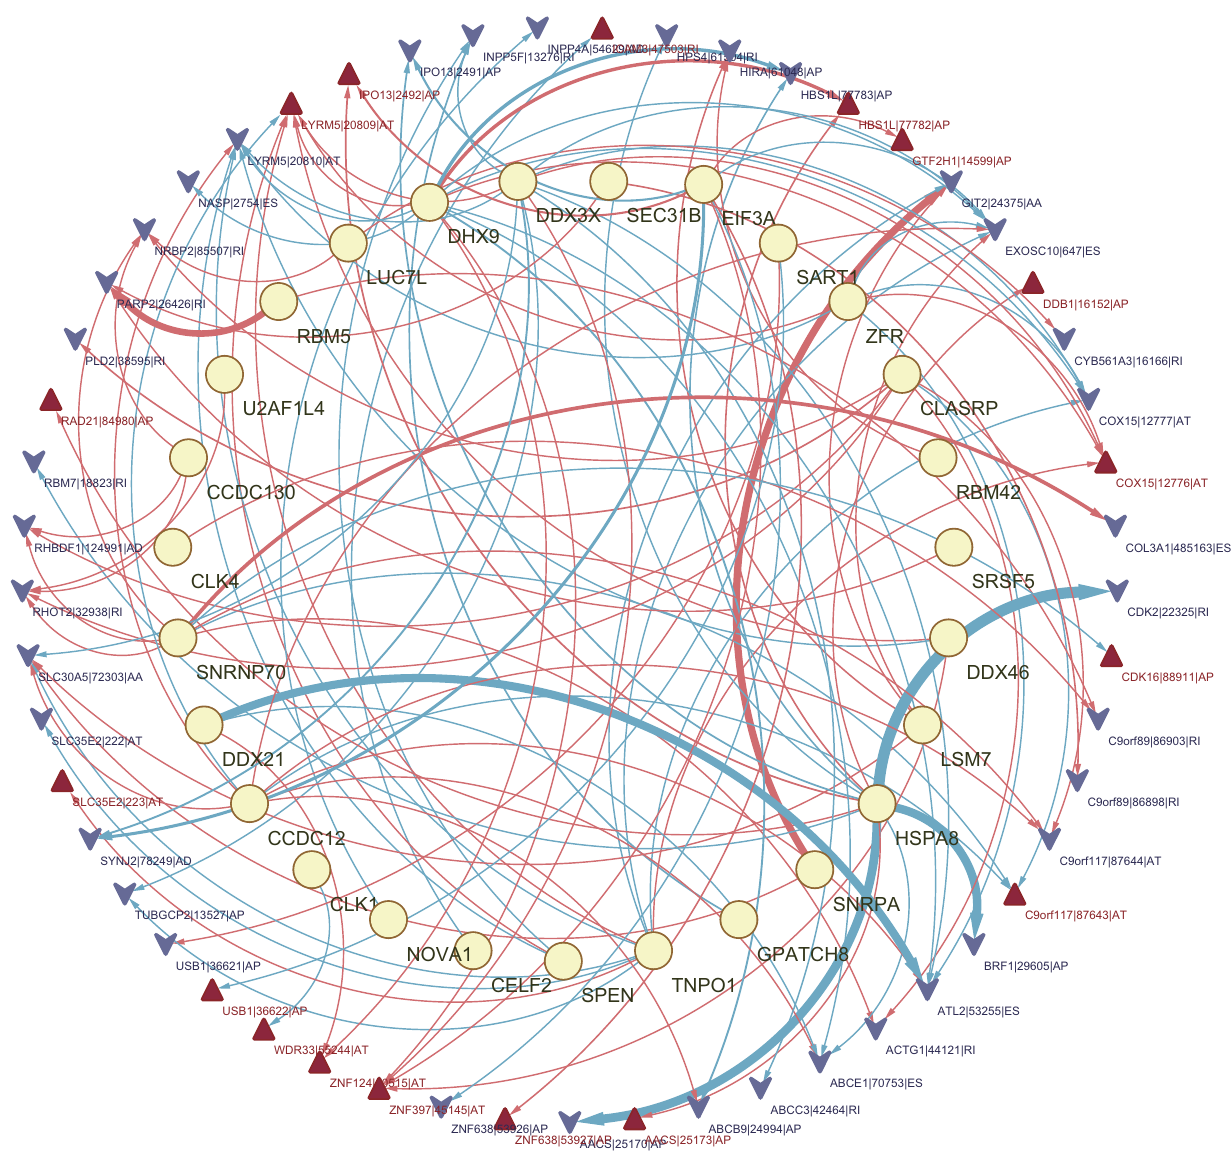
Fig. 6 Network of prognostic SF-AS in TCGA-BRCA. The yellow ellipse represents splicing factors, the red regular triangle represents risk AS events, and the blue inverted arrow represents protective AS events. The red/blue line represents positive/negative regulation between AS events and SF, and the thickness of the line represents the correlation